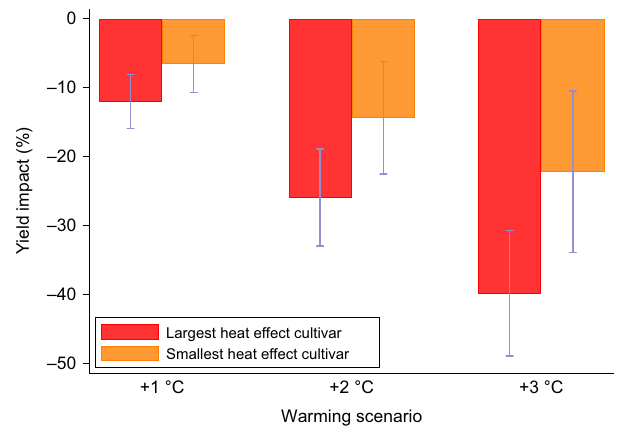
Fig. 6 Comparison of warming impacts on wheat yields for the cultivars with the largest and smallest heat effects. We allow the effect of temperature exposures above 30 °C to vary across cultivars. Impacts are reported as the percentage change in mean yield under + 1 to + 3 °C warming scenarios relative to historical climate. Each 2-bar cluster shows warming impacts for the cultivars with the largest and smallest heat effect. Bars show 95% con fi dence intervals using standard errors clustered by province-year for n = 18,881 yield observations.